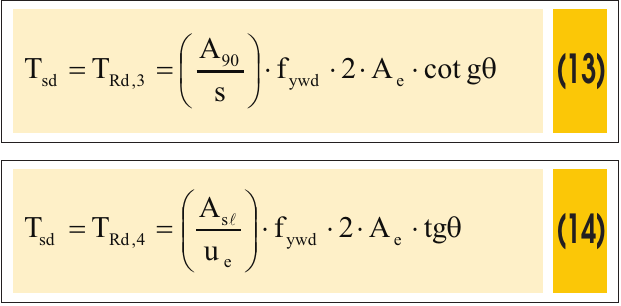
Figure � � Relation �et�een resistance torsion moment relative to compression strut TRd2, for several strut angles T / T Rd2 Rd2, 